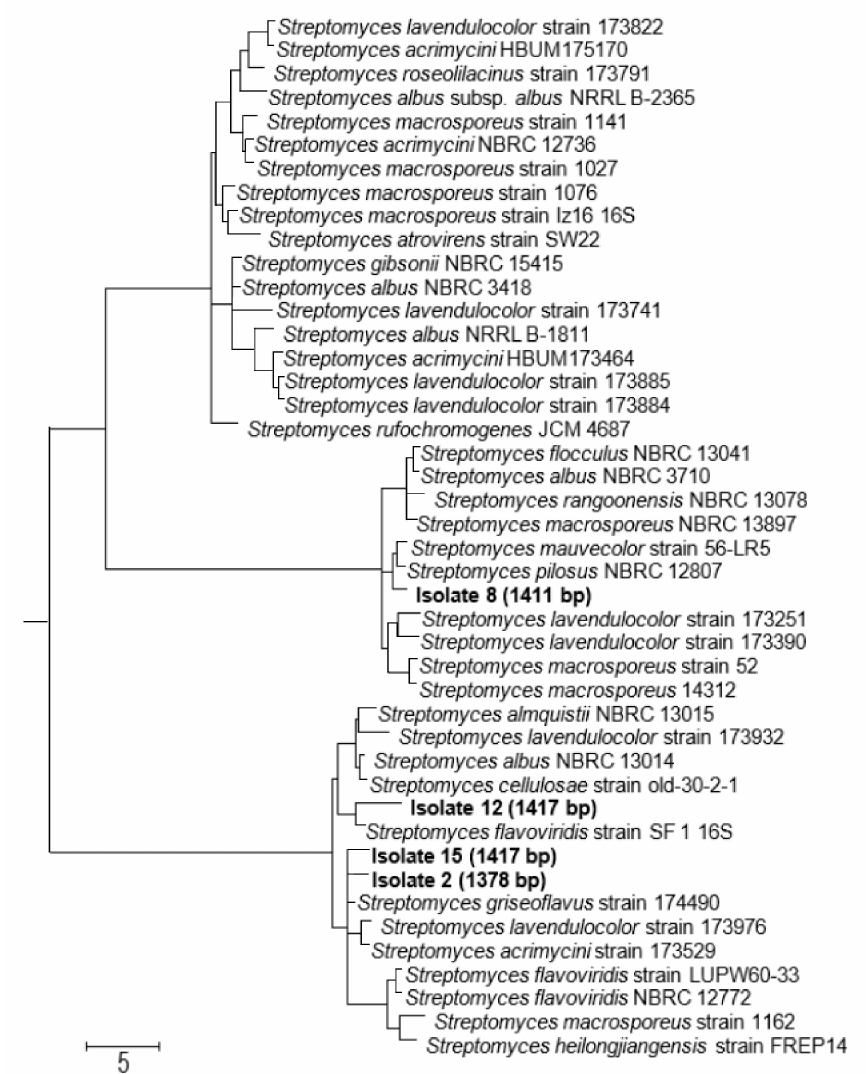
Figure 3. A neighbour joining tree based on 16S rRNA gene sequences showing the relationships between the four selected isolates ( bold font ) and their closely related members of the genus Streptomyces . Numbers at the nodes are percentage bootstrap values based on 1000 resampled datasets; only values above 50% are given. Bar, 0.05 substitutions per nucleotide